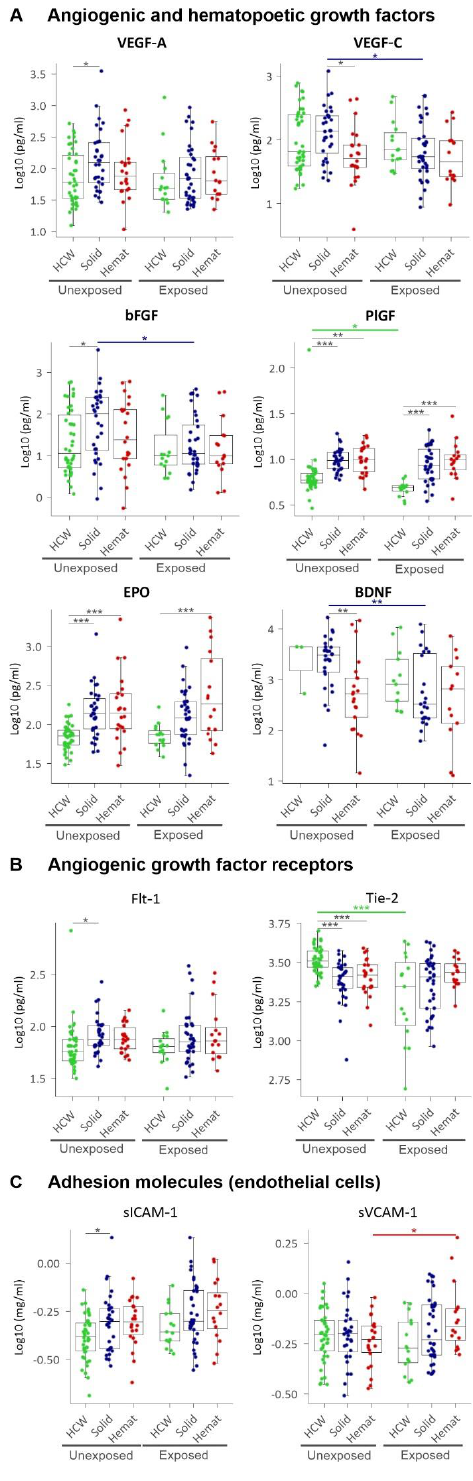
Figure 5. Plasma levels of ( A ) angiogenic and haematopoietic growth factors, ( B ) angiogenic growth factor receptors, and ( C ) adhesion molecules expressed by endothelial cells. HCW, health care workers (green); solid, patients with solid tumours (blue); hemat, patients with haematological malignancies (red). Each dot represents the sample closest to exposure in the case of exposed patients and an average of multiple timepoints, when available, for unexposed patients. * p < 0.05, ** p < 0.01, *** p <